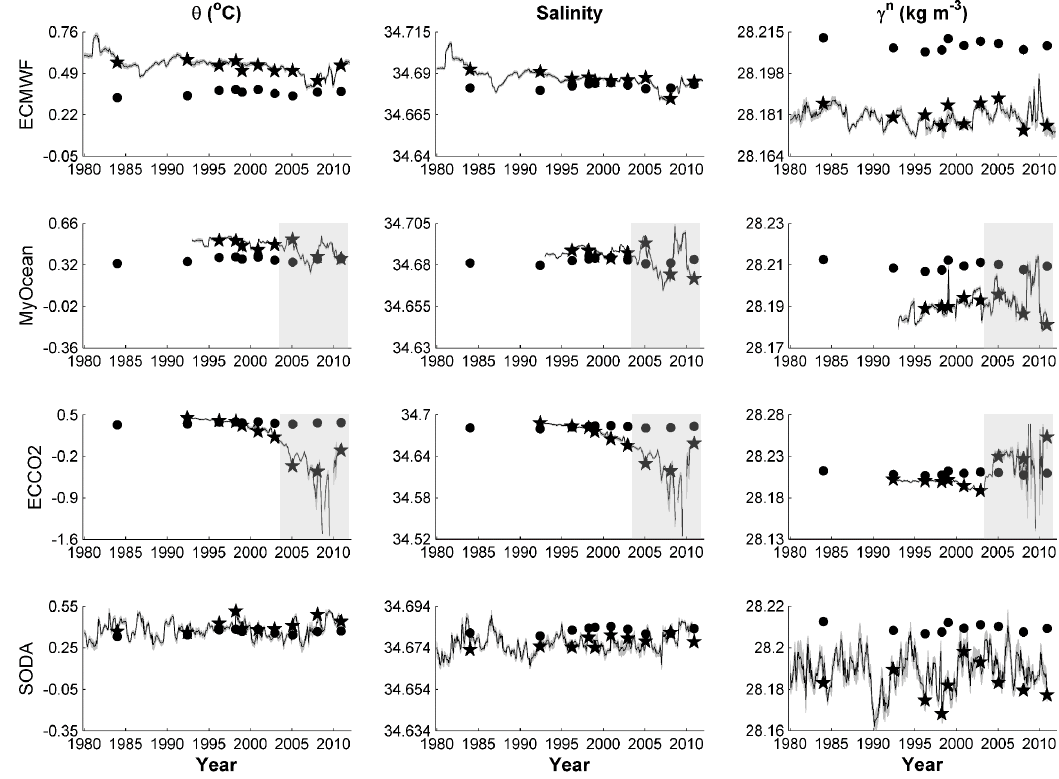
Figure 11. Time series of monthly mean hydrographic properties of WDW in ECMWF, MyOcean, ECCO2, and SODA (top to bottom) averaged along the WOCE A12 section line. From left to right: θ , S , and γ n . The gray shading indicates the standard deviation due to variation caused by the different station locations in the different years of the hydrographic cruises. The dots indicate the values derived from the observed data, and the pentagrams are the values from the corresponding reanalysis data. Note that the scales are different to show the variability in the time series. The gray rectangles denote the period in which the hydrographic properties showed anomalous variability.